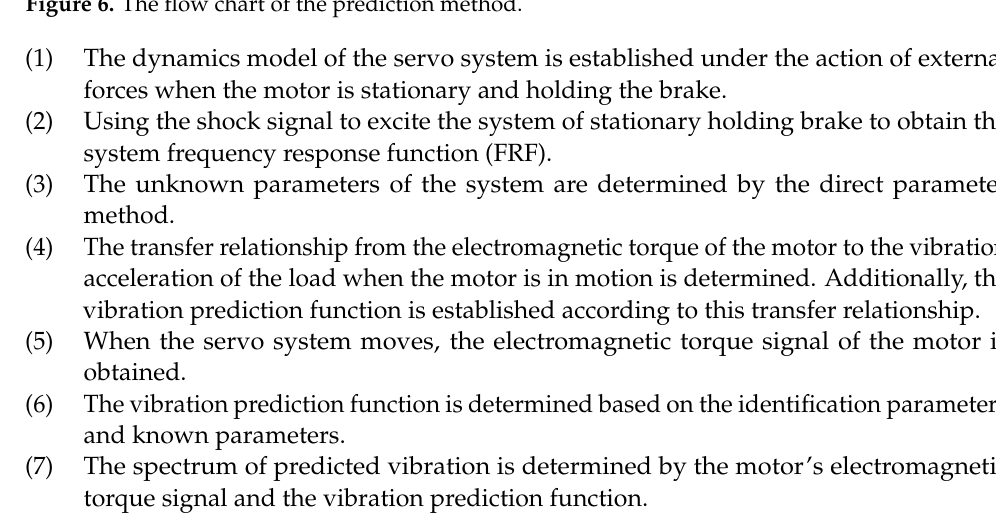
Figure 6. The flow chart of the prediction method.